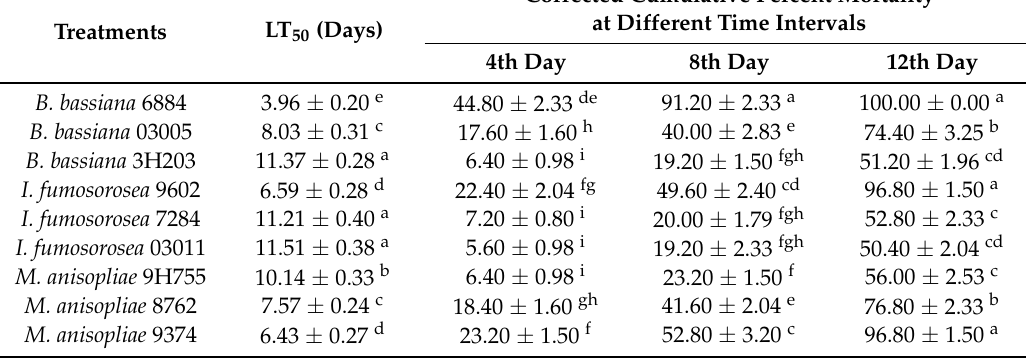
Table 2. Average corrected percent mortality of Rhynchophorus ferrugineus larvae infected with different isolates of entomopathogenic fungi.